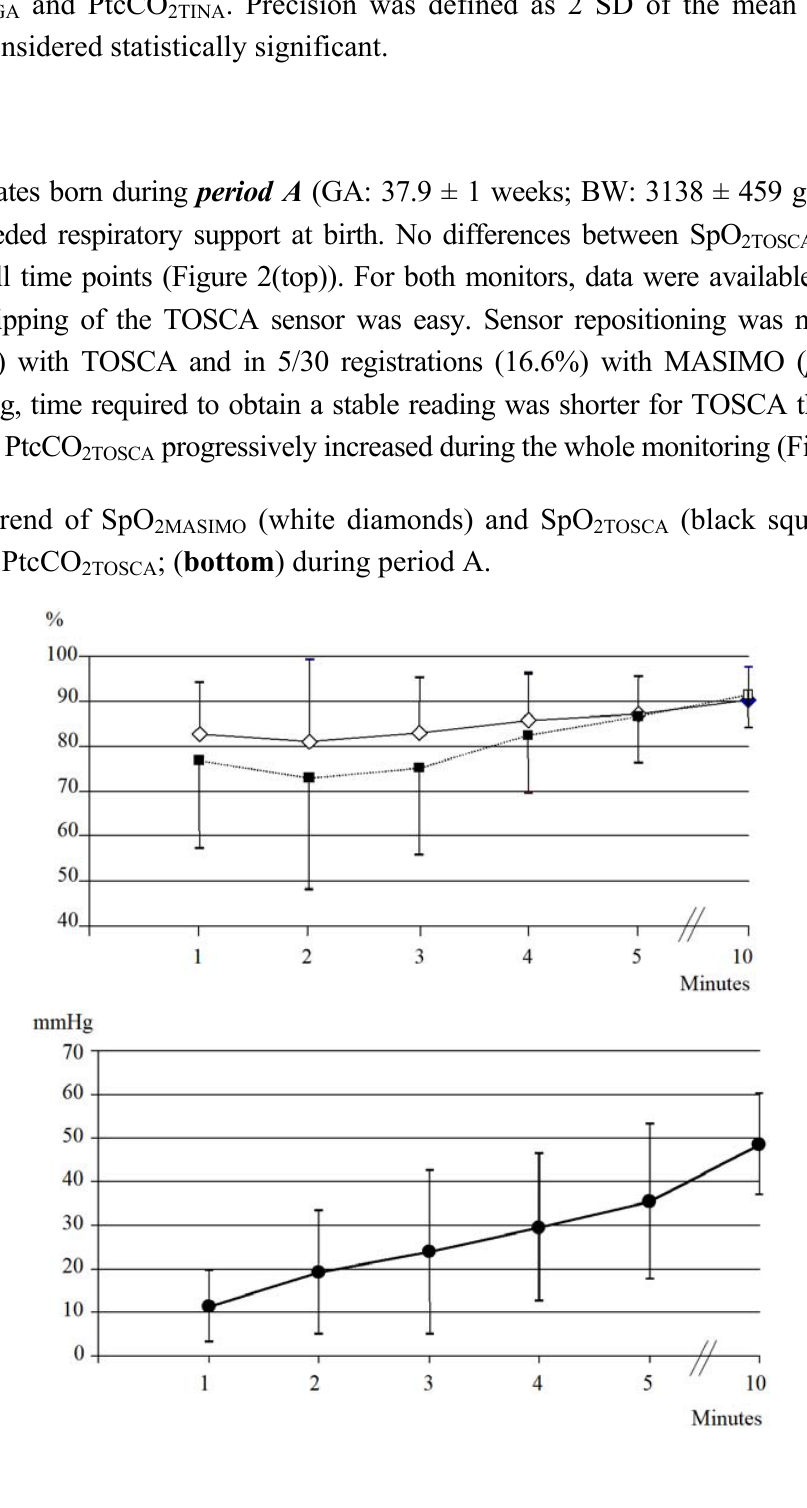
(black squares) ( top ), 2TOSCA